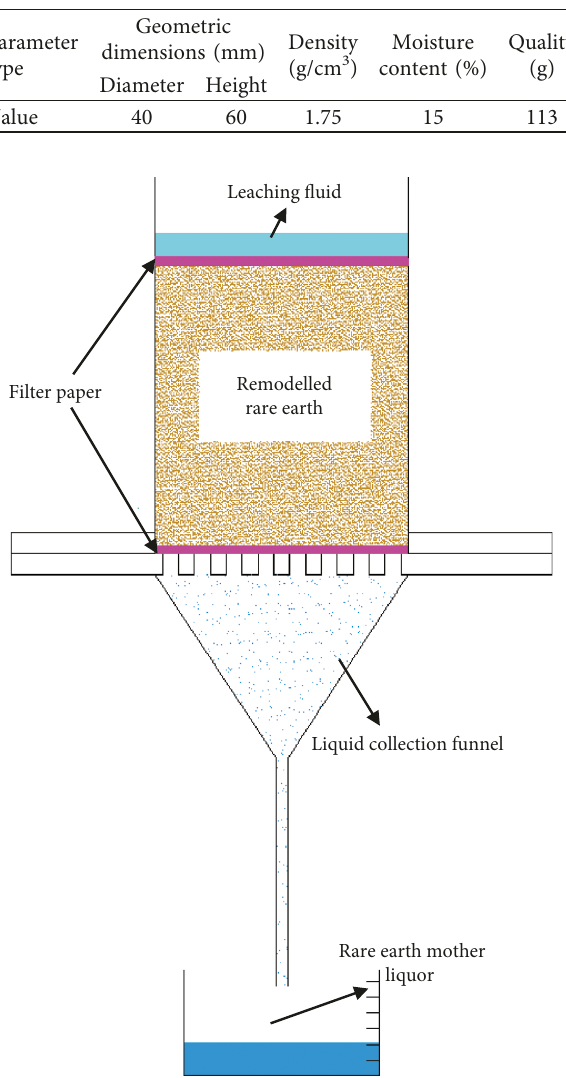
Figure 2: Column leaching test device.